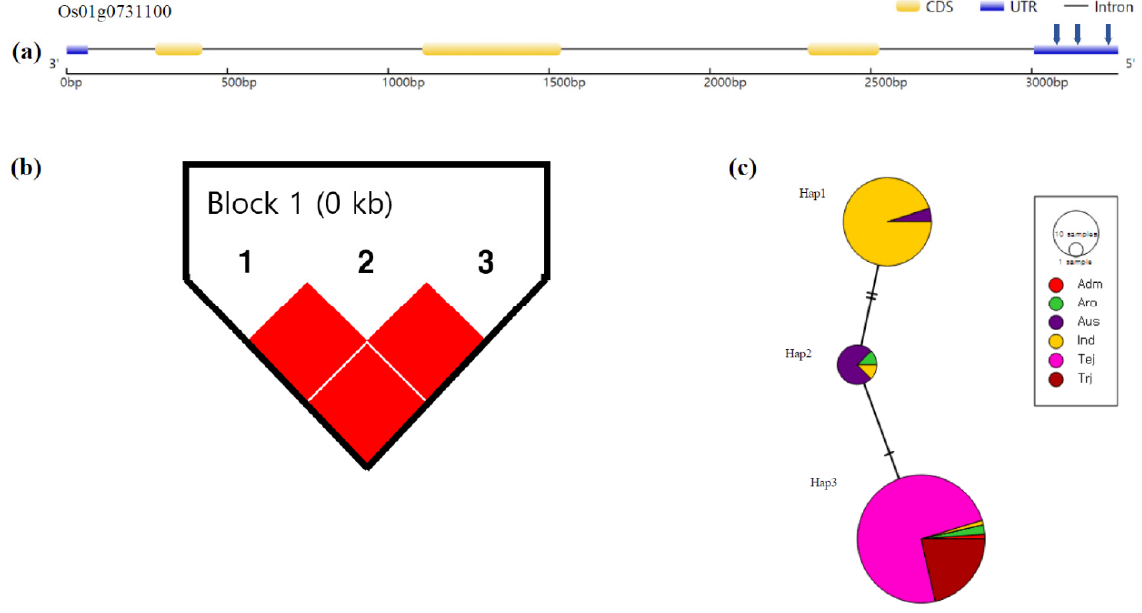
Figure 5. Haplotype analysis of Os01g0731100 . ( a ) Schematic representation of gene structure and SNPs positions in Os01g0731100 . Yellow, blue blocks and gray line represent exon, untranslated region (UTR) and intron regions, blue vertical bars represent SNPs. ( b ) Linkage disequilibrium (LD) analysis of SNPs in Os01g0731100 . D’ was used to indicate LD level, with LD blocks defined using the Confidence Intervals function in the analysis software. Red blocks indicate complete LD between each SNP. ( c ) Haplotype variation analysis. Colors indicate rice subspecies as indicated in the legend. Circle size indicates the number of varieties in each Hap. Traverse lines represent the extent of variation between three haplotypes. Table 3. Results of haplotype analysis of Os01g0731100 .